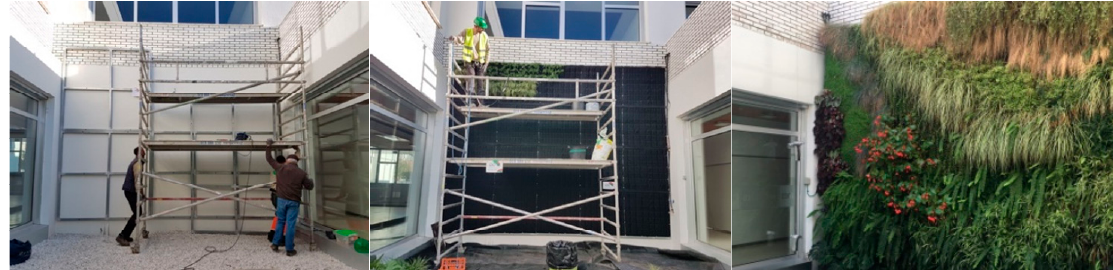
Figure 11. The installation process of the vegetal facade in case study 2.